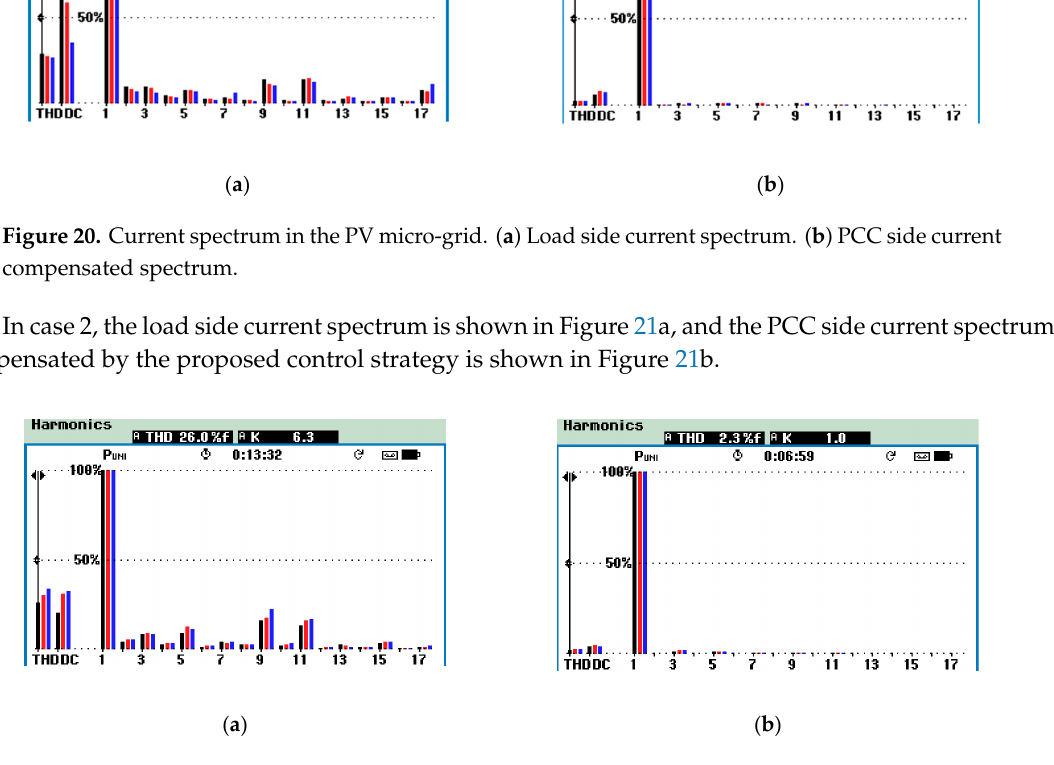
Figure 21. Current spectrum in the PV micro-grid. ( a ) Load side current spectrum. ( b ) PCC side current compensated spectrum.